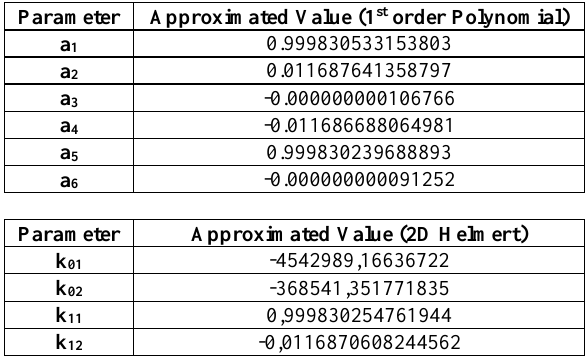
Table 4. Calculated transformation coefficients for 1 st Order polynomial and Helmert transformation